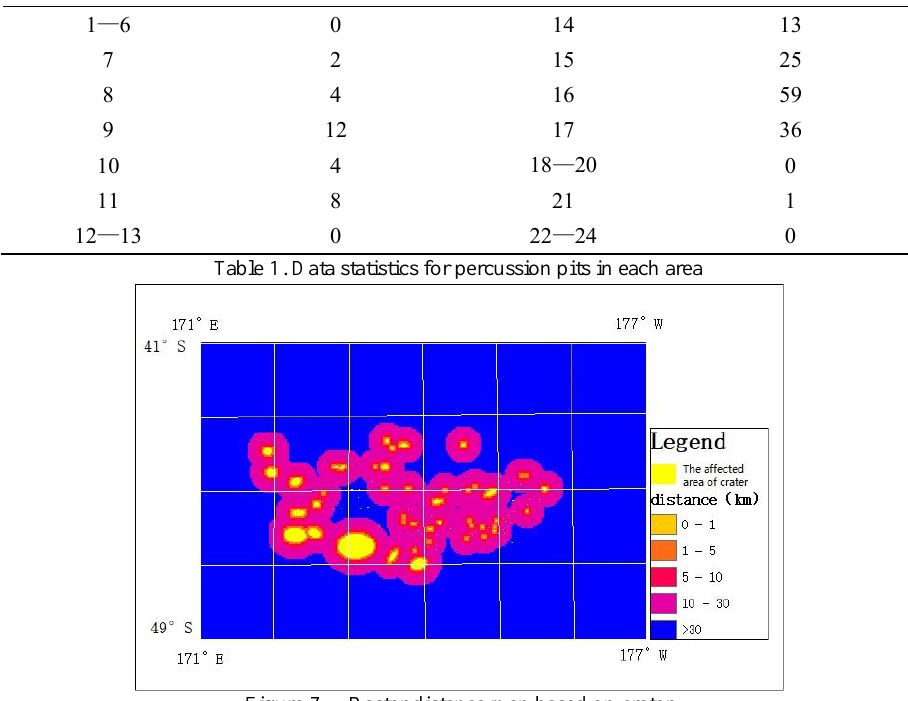
Figure 7. Raster distance map based on